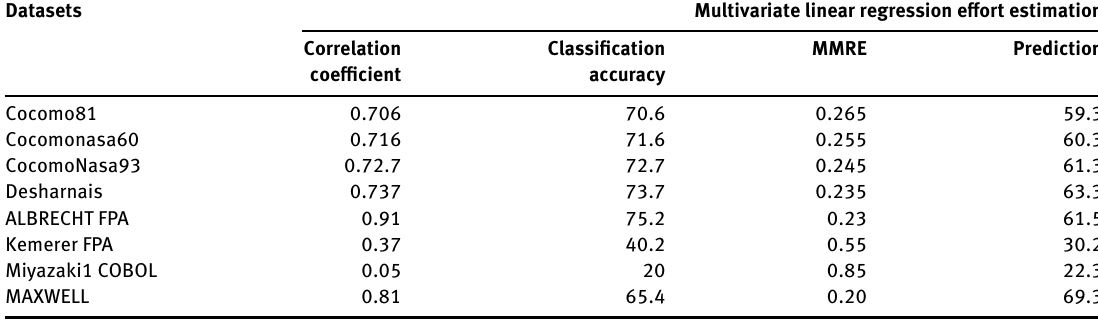
Table 1: Validation Parameters’ Values for Multivariate Linear Regression Effort Estimation.